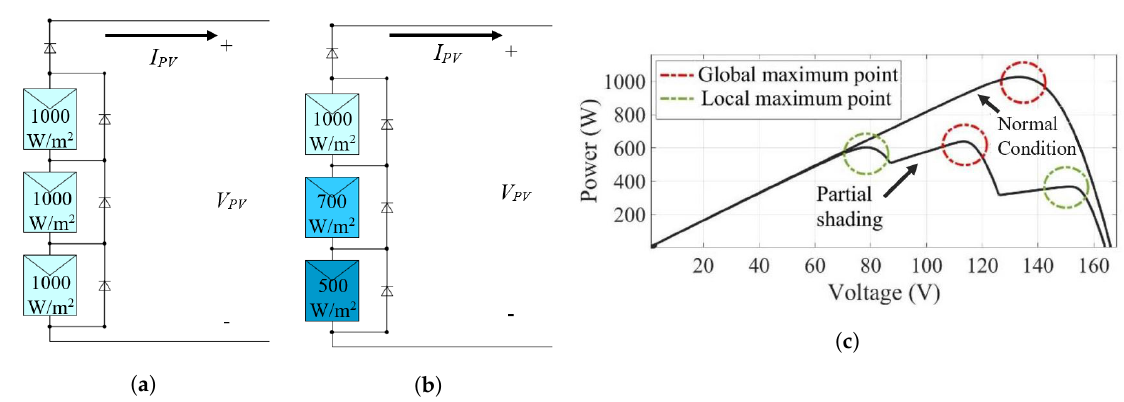
Figure 1. ( a ) Normal condition at 25 ◦ C, ( b ) partial shading condition at 25 ◦ C, ( c ) power-voltage (P-V) characteristic curves for both